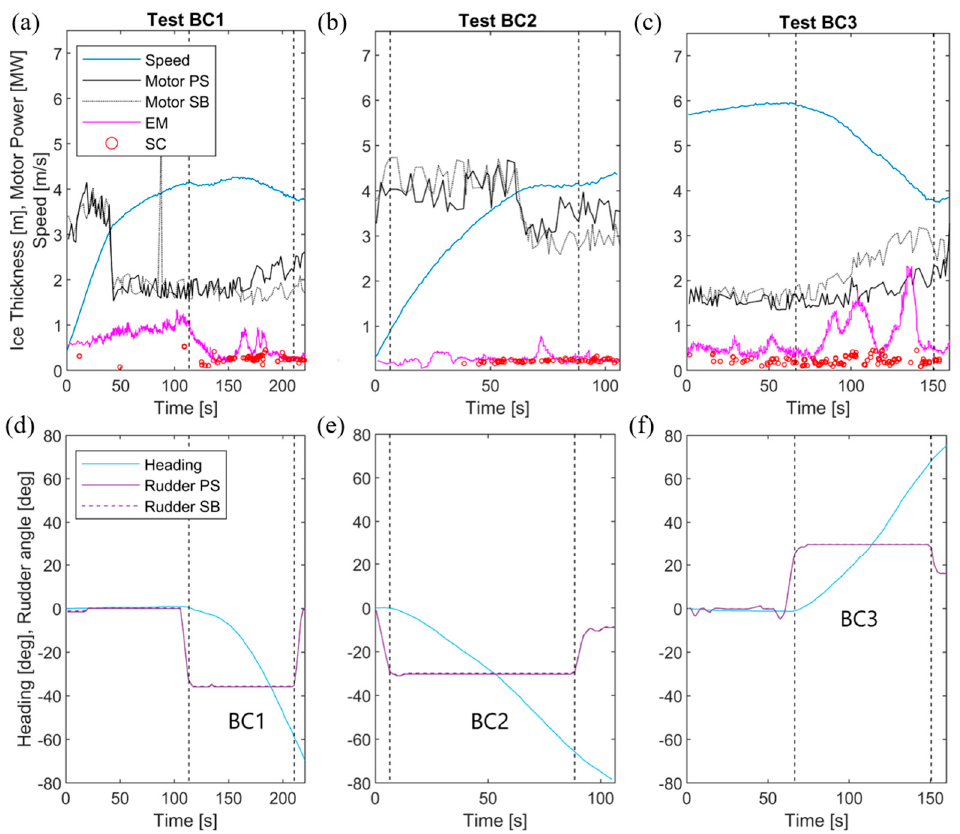
Figure A4. Applied motor power, measured ice thickness with the electromagnetic device (EM) and stereo camera system (SC), and obtained speed during tests ( a) BC1, ( b ) BC2, and ( c ) BC3. Applied rudder angles with obtained heading during tests ( d ) BC1, ( e ) BC2, and ( f ) BC3.